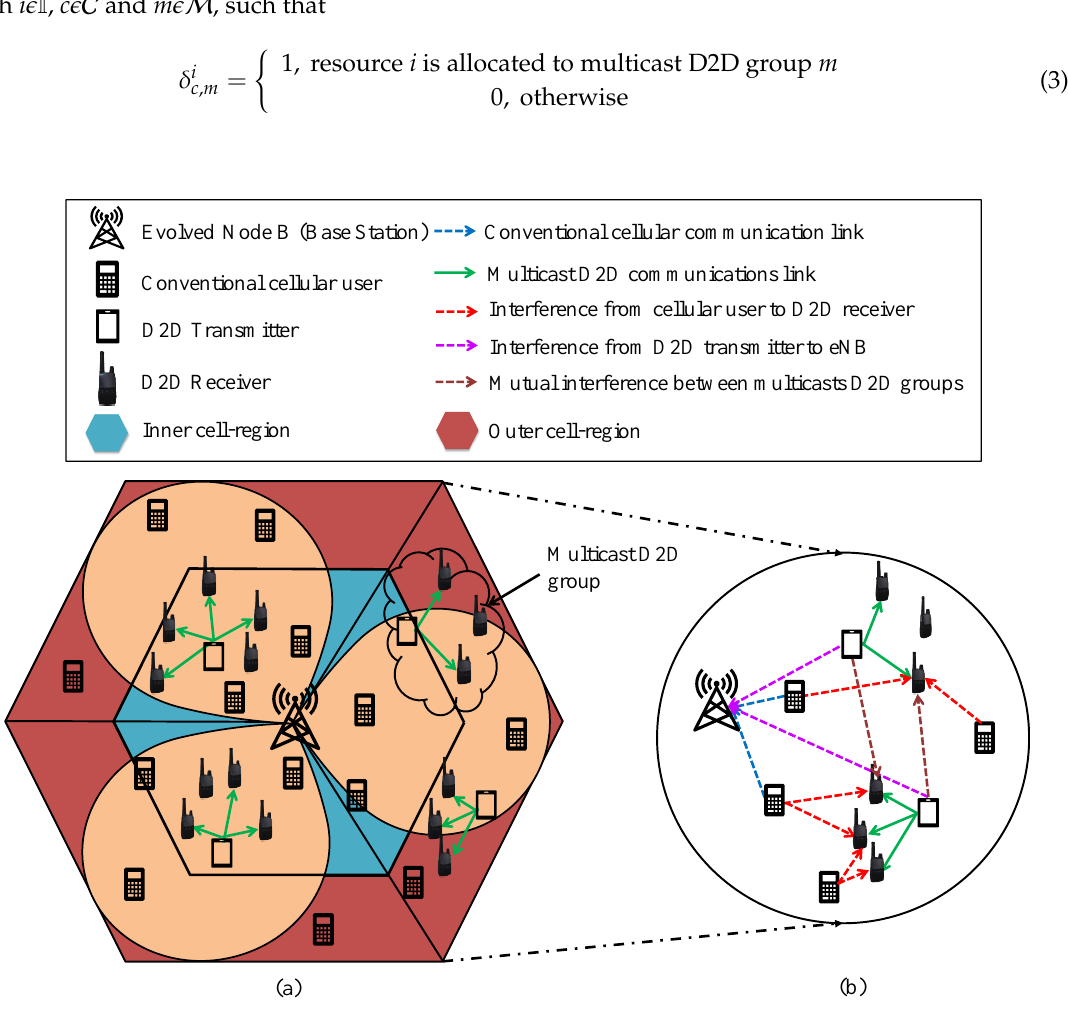
Figure 1. Spectrum partitioned in fractional frequency reuse (FFR) scheme using three 120°- directional antennas.